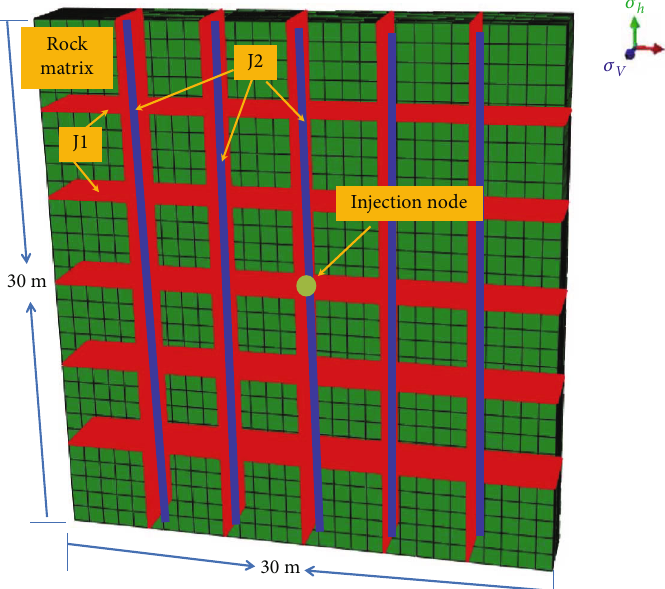
Figure 15: Schematic diagrams of complex hydraulic and natural fracture joint system interactions in a 3D domain, where J1 (red region) with a 4m formation thickness is along the orientation of σ , J2 (blue region) with a 2m formation thickness is along the orientation of σ H is along the height of this and the overburden stress σ v